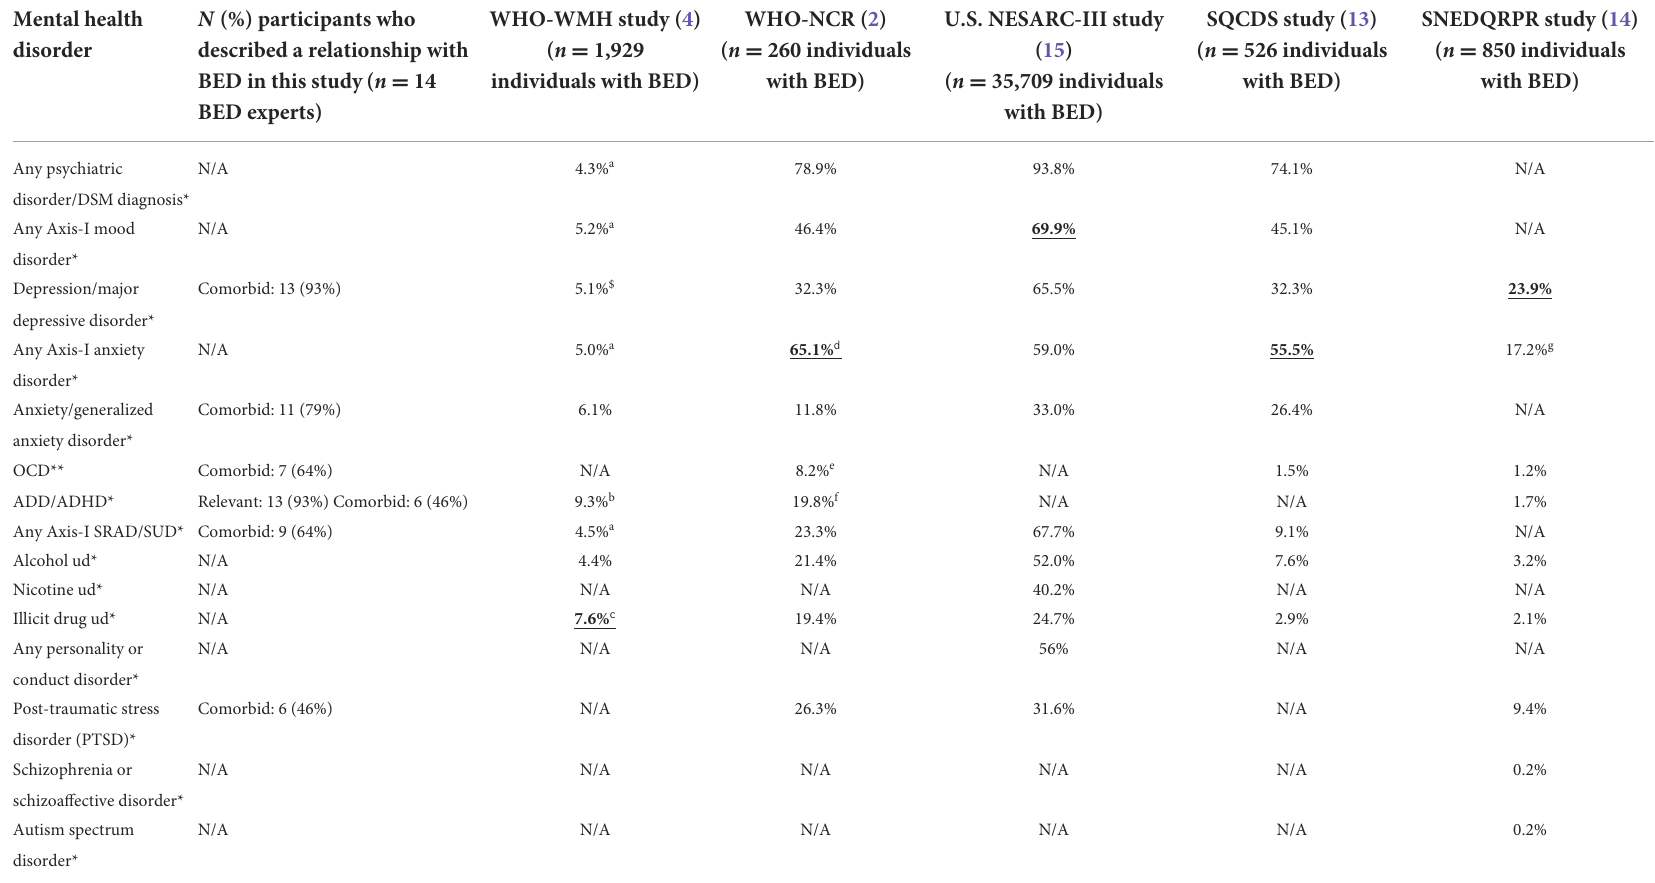
TABLE 1 Participant recognition of mental health disorders comorbid with BED (as identified in this study) in comparison to lifetime prevalence rates of various mental health disorders found in sample populations of current global and national prevalence